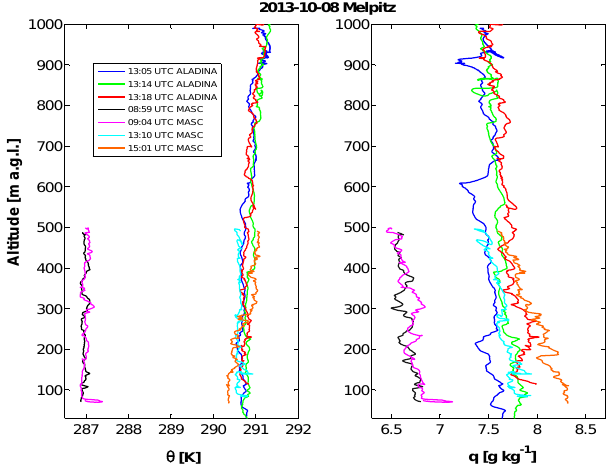
Figure 10. Vertical profiles of (a) potential temperature θ and (b) water vapour mixing ratio q measured with MASC and ALADINA in Melpitz on 8 October